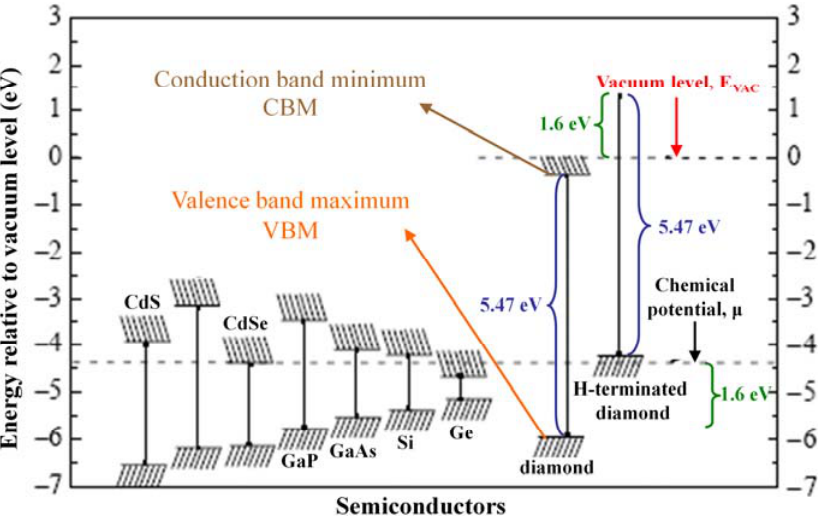
Figure 7. Energies of the valence and conduction band edges of several conventional semiconductors, including H-terminated and as-grown diamond relative to the vacuum . The lower dashed line represents the chemical potential, µ, for electrons in an level, E VAC acidic electrolyte under the conditions of a standard hydrogen electrode